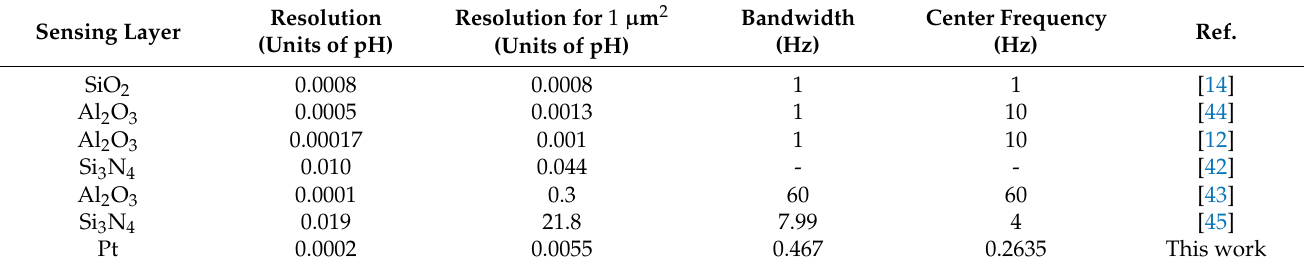
Table 3. Comparison of the resolution obtained in this work with other pH sensitive ISFETs in the